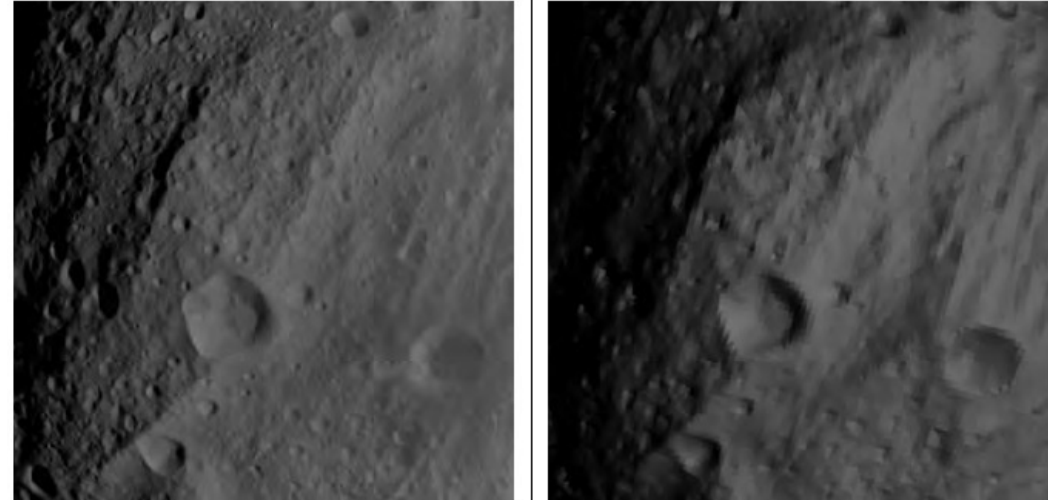
Figure 18. Left: real image as acquired by DAWN Framing Camera FC2. Right: simulated image, 196608-triangle-model of Vesta with 1024 × 1024 px camera resolution. Image ID FC21B0007807- ≈ 26232214089F1B.FIT , χ 2 s